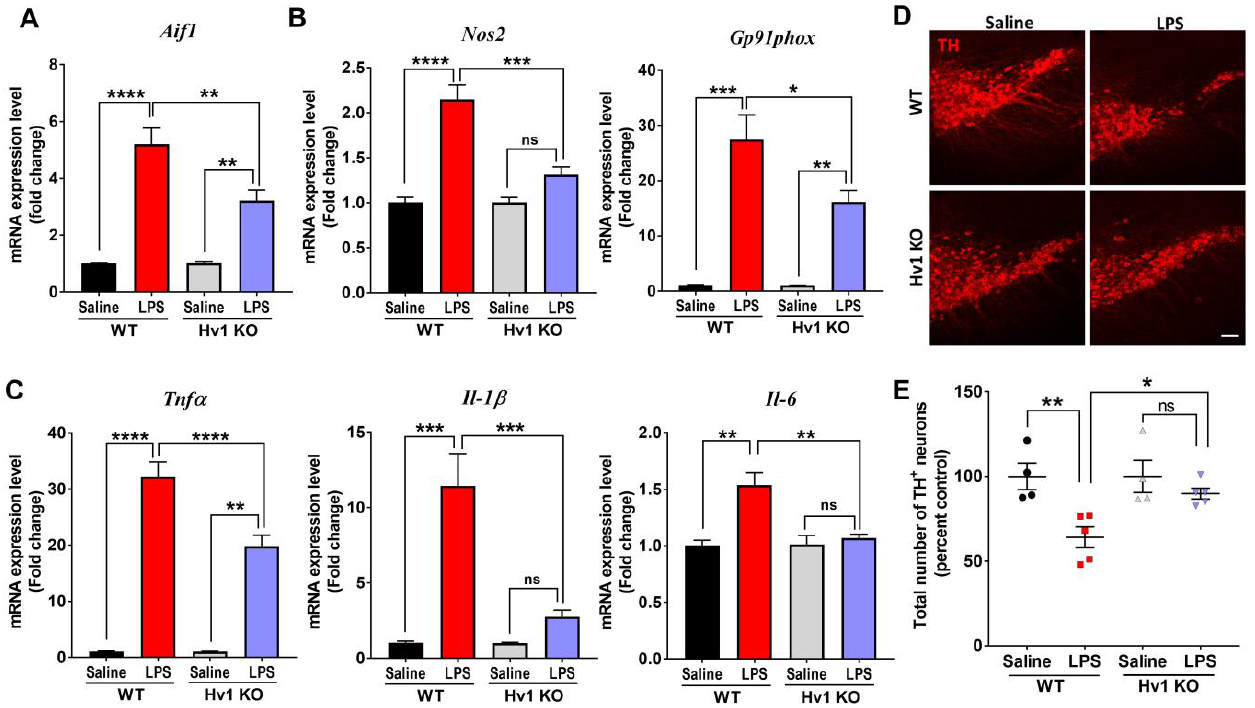
Figure 6. Hv1 KO mice exhibit reduced inflammatory response and protection of TH-positive neurons in an LPS model of PD. ( A – C ) Quantitative PCR mRNA levels of inflammatory factors in the striatum of WT or Hv1 KO mice following sub-chronic LPS treatment, including mRNA levels of Aif1 ( A ), Nos2, and Gp91phox ( B ), and pro-inflammatory cytokines Tnfα , Il- 1β , and Il-6 ( C ). ( D ) Representative 10 × immunofluorescent images for TH-positive neurons in the SN following treatment of LPS in WT and Hv1 KO mice, scale bar 100 µm. ( E ) Stereological counts for a total number of TH-positive neurons in the SN following subchronic LPS treatment in each genotype. n = 4 – 5 mice per group for all experiments. Asterisks denote statistically significant differences — * p < 0.05, ** p < 0.01, *** p < 0.001, and **** p < 0.0001, using two- way ANOVA followed by Tukey’s multiple comparisons. ‘ns’ indicates not statistically significant. Error bars denote the standard error of the mean.